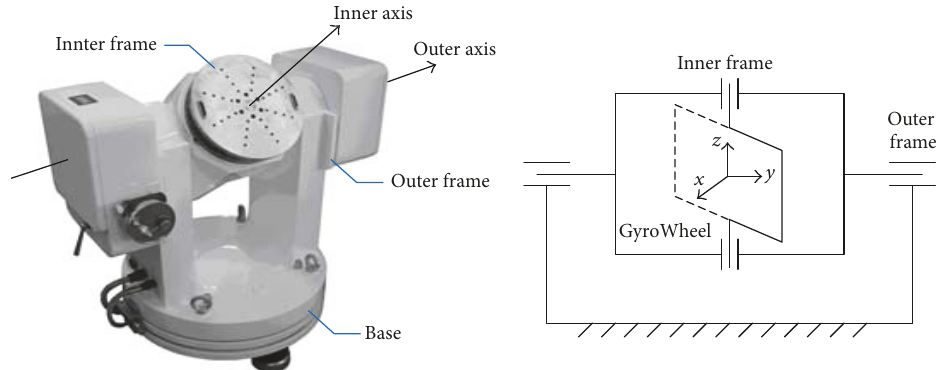
Figure 2: Schematic representation of a two-axis